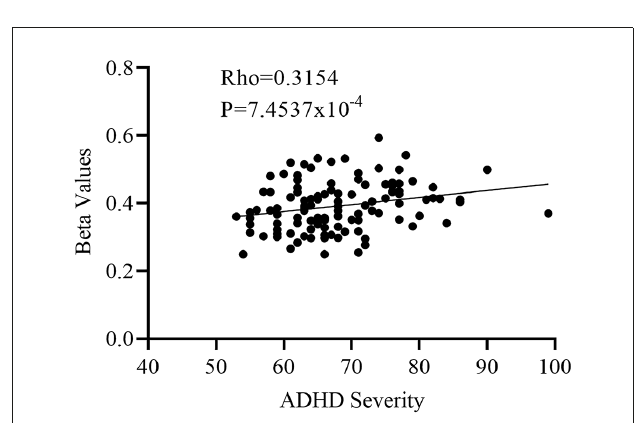
FIGURE2 Partial correlation between the right pallidum and overall disease severity with the right pallidum showing a positive relationship with overall disease